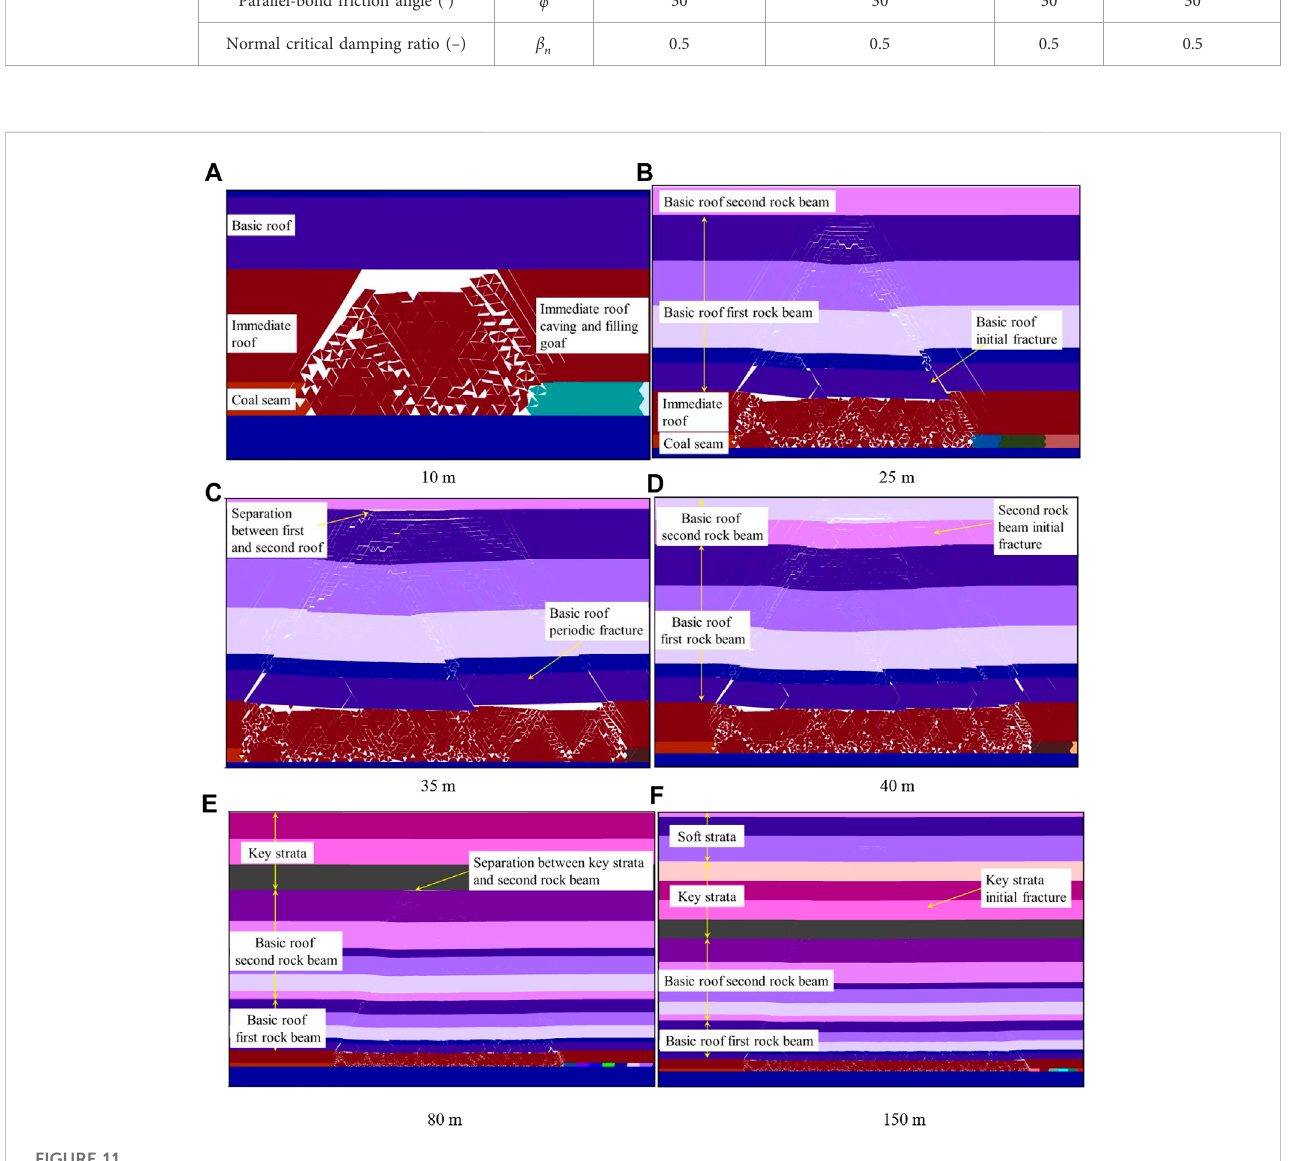
Frontiers in Earth